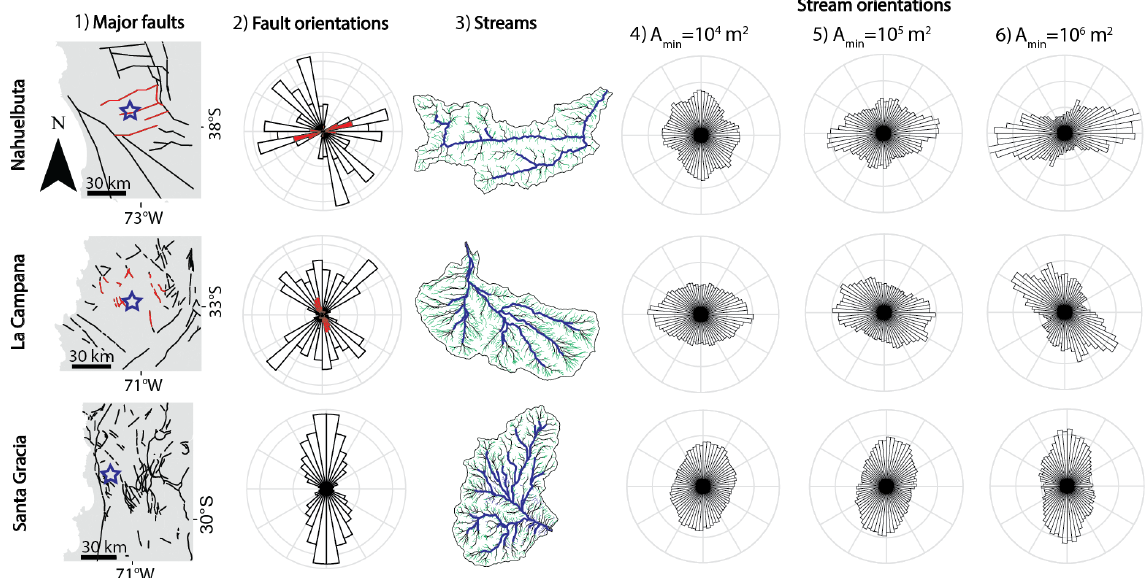
Figure 7. Rose diagram plots and maps showing fault and stream orientations for Nahuelbuta (top row panels), La Campana (middle row panels), and Santa Gracia (bottom row panels). For each field site, the columns show the following from left to right: (1) major faults digitized from a geological map (SERNAGEOMIN, 2003) within ∼ 50km (black) and ∼ 25km (red, NA and LC only) of the sampling site (blue star); (2) rose diagram of fault orientations from the maps in column 1, constructed using 100m long, straight fault segments and 36 bins, with orientations of faults < 25km from NA and LC in red; (3) a map of the studied catchments and the drainage network, with green, black, and blue streams indicating minimum upstream areas ( A min ) of 10 4 , 10 5 , and 10 6 m 2 , respectively, derived from 1m resolution lidar DEMs (Kügler et al., 2022); (4–6) rose diagrams (72 bins) of stream orientations for different A min . All maps and rose diagrams are oriented with the top being